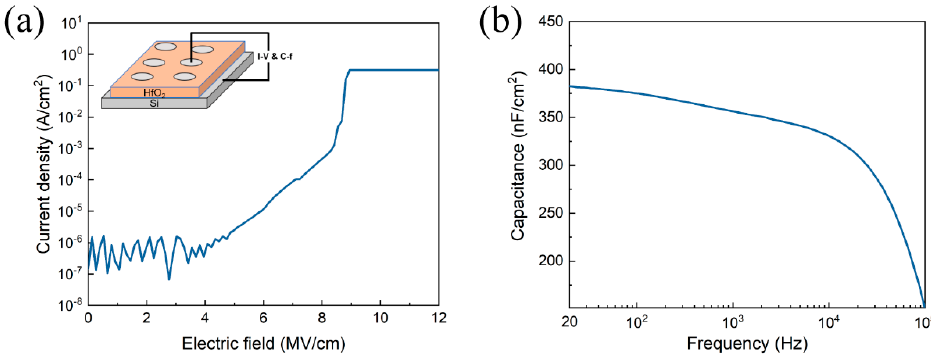
Figure 6. ( a ) The leakage current density and ( b ) capacitance–frequency characteristics of HfO 2 dielectric. Inset: the schematic of the capacitor.